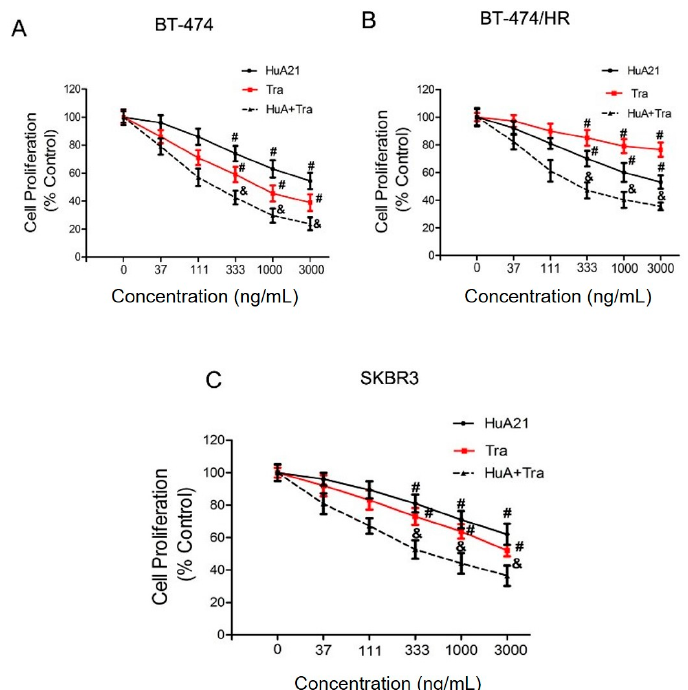
Figure 1. HuA21 suppressed the proliferation of breast cancer cells. The inhibitory effects of HuA21, trastuzumab (Tra), or the combination on the growth of the: BT-474 ( A ); BT-474/HR ( B ); and SKBR3 ( C ) cells. The cells were incubated with HuA21 or Tra at the indicated concentrations for 72 h. Cell viability was measured by the the cell counting kit-8 (CCK-8) assay. The curve charts represent the cell viability of the: BT-474 ( A ); BT-474/HR ( B ); and SKBR3 cells ( C ). The experiments are performed in triplicate, and the data are representative of three separate experiments. # p < 0.05 vs. control; & p < 0.05 vs. HuA21-treated cells.